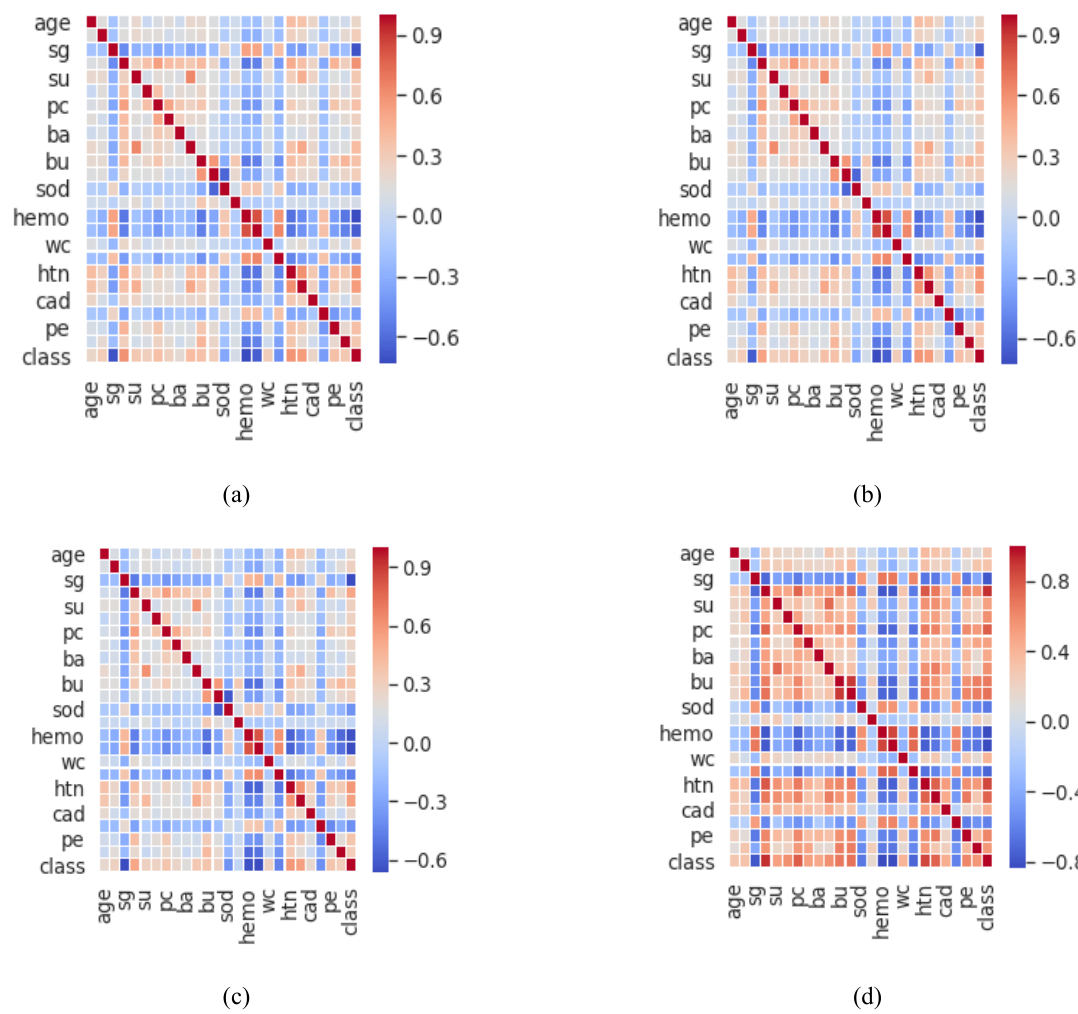
Figure 1. Correlation heatmap of different data frames (a) mean (b) median (c) mode and (d) no